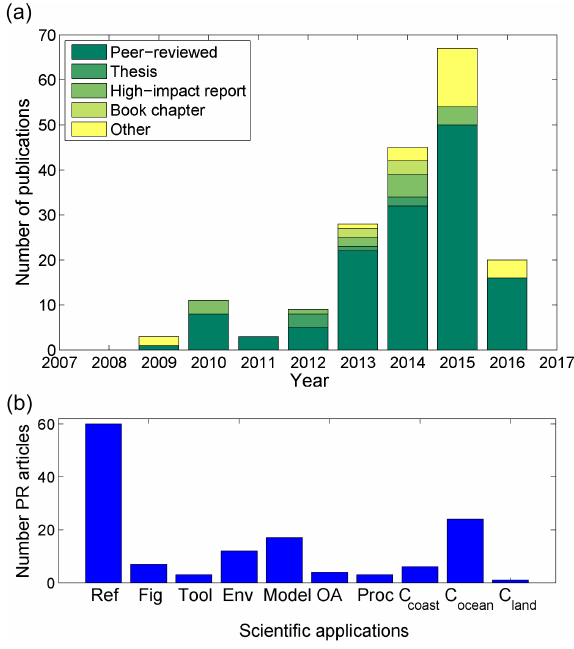
Figure 7. (a) Number of publications citing or naming SOCAT per year by type of publication and (b) scientific applications of SOCAT in peer-reviewed, scientific articles. The number of pub- lications in 2016 only includes publications before 22 April 2016. Types of publications are peer-reviewed, scientific articles, PhD and MSc theses, high-impact reports, book chapters and all other pub- lications. Scientific applications in peer-reviewed, scientific articles are grouped as reference (only) to the SOCAT data synthesis; use of figures or tools based on SOCAT; use of surface ocean f CO 2 values for various environmental studies; modelling; trend analysis in ocean acidification studies; f CO 2 process studies; and carbon budgeting of coastal seas, open ocean and land systems. These sci- entific applications are discussed in Sects. 7.2 and 7.3. A list of publications citing or naming SOCAT is available on the SOCAT website